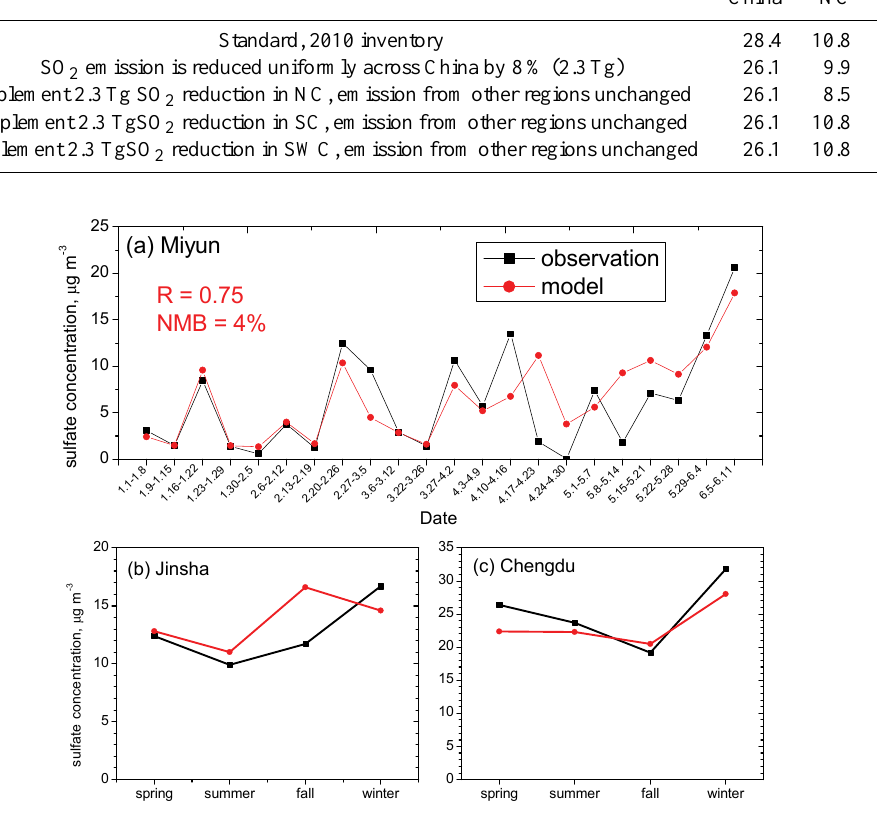
Figure 5. Comparison of observed (black line) and simulated (red line) surface sulfate concentrations at (a) Miyun site with weekly sulfate concentration from January to June in 2010; (b) Jinsha site with seasonal mean sulfate concentration from Zhang F. et al. (2014); the observation year is 2012; (c) Chengdu site with monthly mean sulfate concentration from Tao et al. (2014); the observation time is January, April, July, and October in